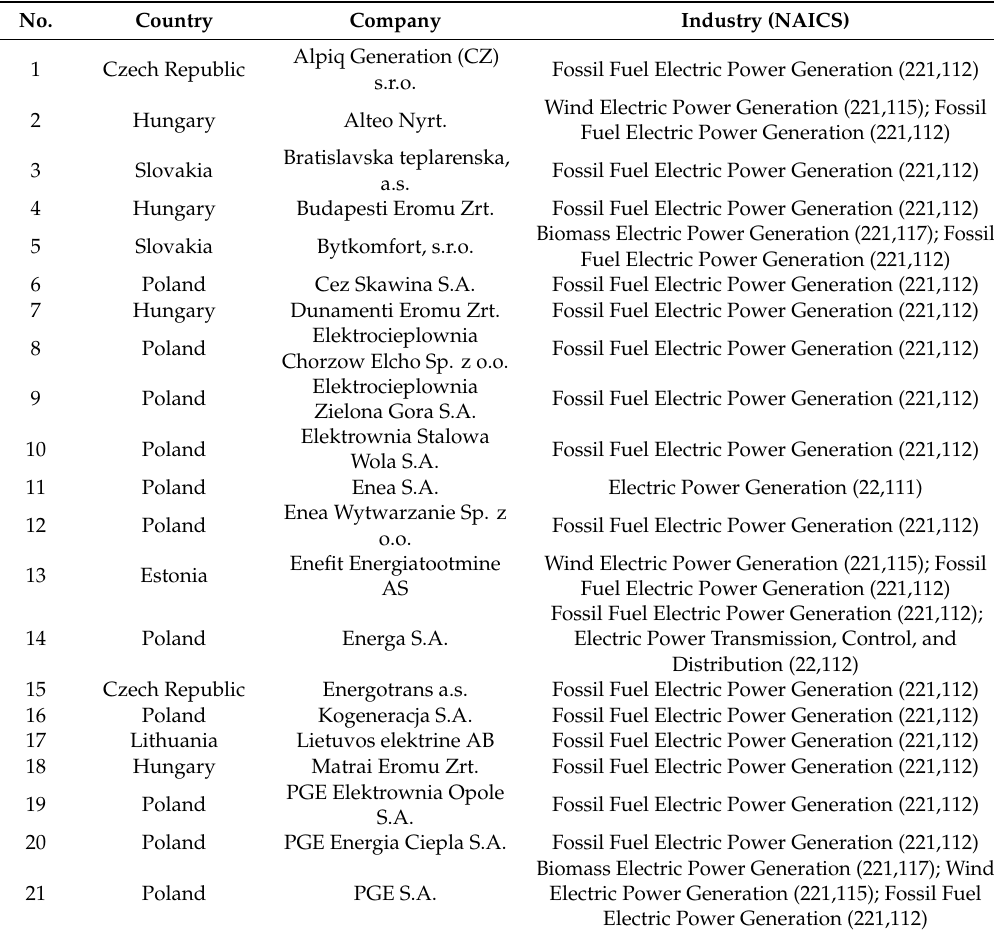
Table 1. The sample of 37 energy companies analysed in this paper. The last column includes NAICS (North American Industry Classification System) codes for easier